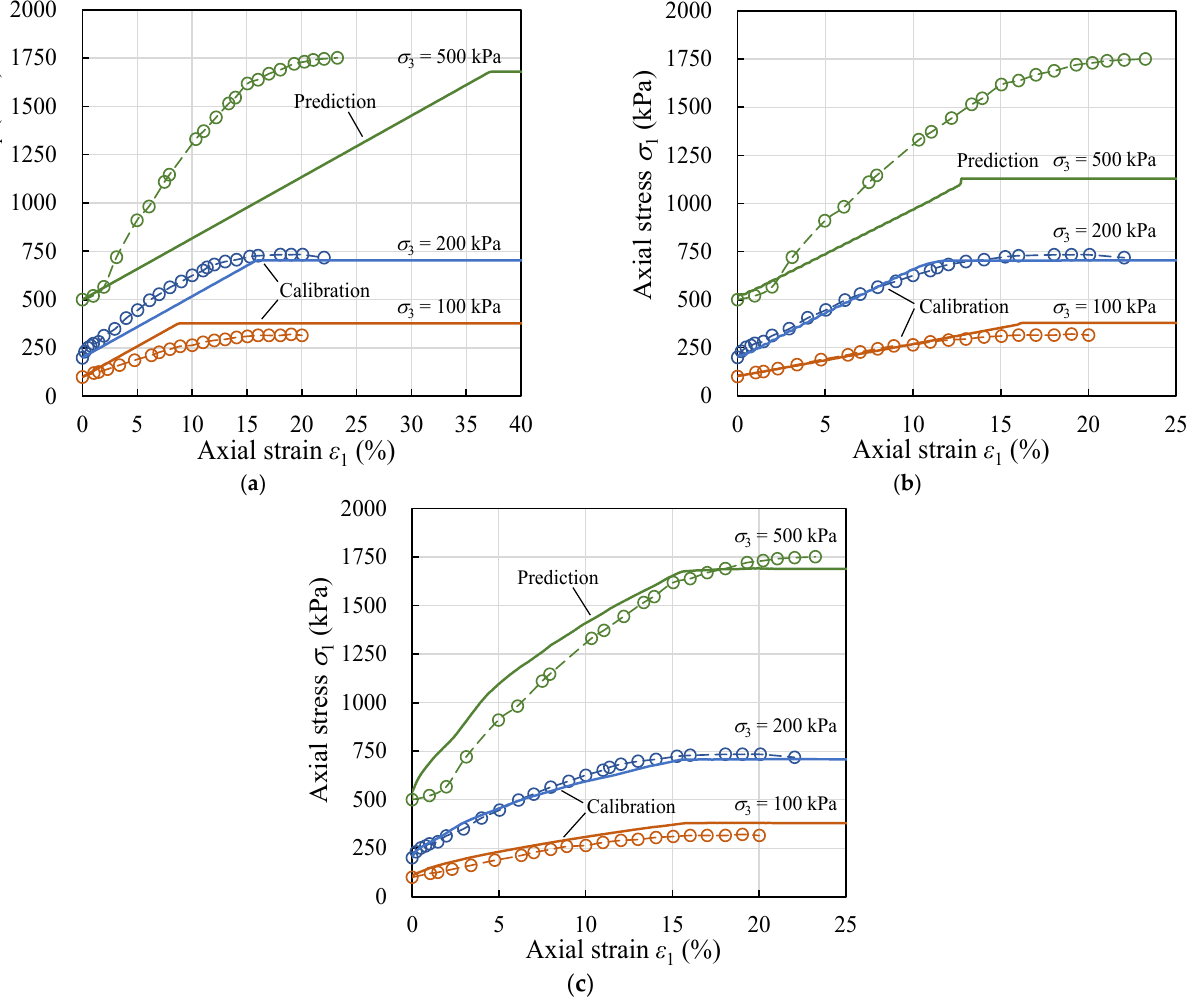
Figure 9. Comparisons between the experimental results (dash lines with points) of consolidated drained triaxial compression tests reported by Rankine [28] and the numerical results (solid lines) under different confining pressures by applying the ( a ) Mohr–Coulomb; ( b ) double ‐ yield and ( c ) Soft Soil models for backfill with parameters in Table 2.